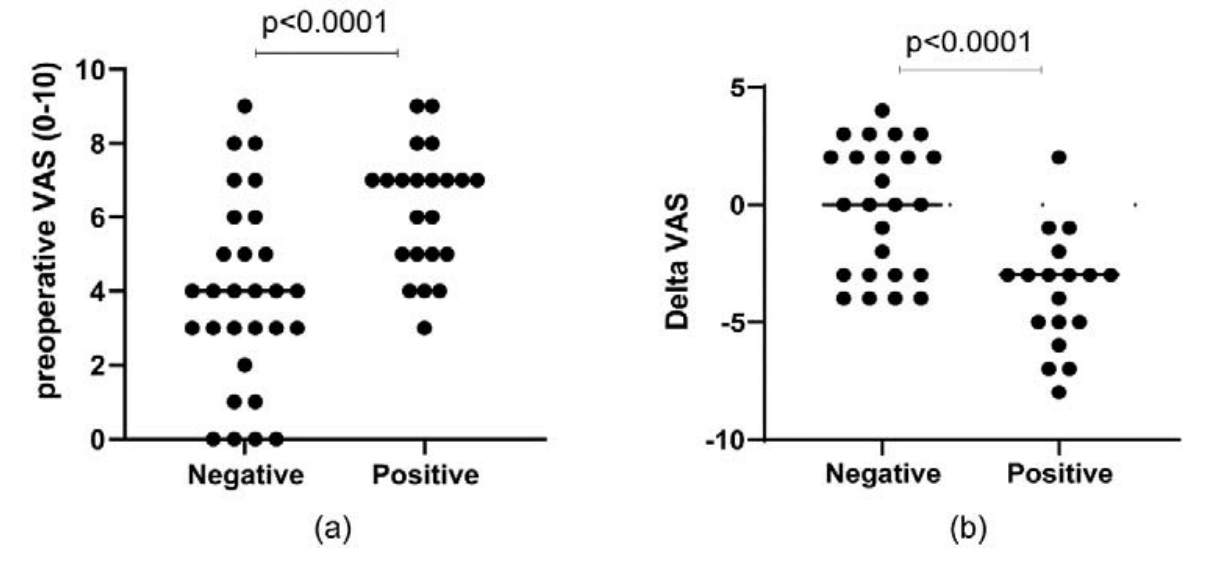
Figure 6. Plots showing the preoperative ( a ) and delta VAS ( b ) in patients with negative or positive MMP ‐ 13.